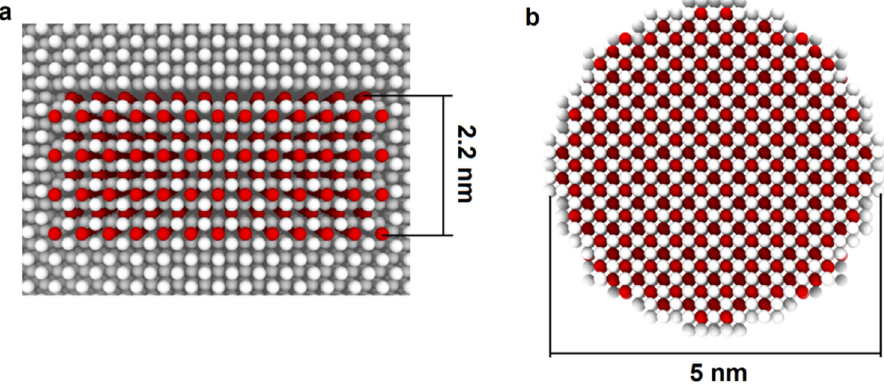
Figure 1. Structure and form of θ ’ precipitate. Panel ( a ) is cross section of matrix-surrounded precipitate and ( b ) is view of inclusion flat surface without aluminum matrix Aluminum atoms are colored in gray, copper atoms are red.